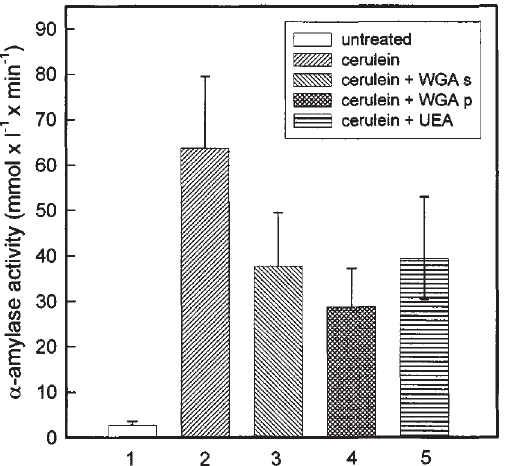
Fig. 4. The (cid:11) -amylase activity (mmol/l (cid:2) min) in the serum of rats after induction of cerulein pancreatitis and ip administration of cerulein and lectins. The results are expressed as mean (cid:6) standard derivation (SD) (groups 1–4, normally distributed) or median (group 5, non-normally distributed). Serum amylase activity of untreated (NaCl) animals (group 1), cerulein treated rats (group 2) and lectin treated animals (groups 3, 4, 5). Significant decrease of enzyme levels by simultaneous WGA administration (compare groups 2 and 3, p < 0.001). Strongest inhibitory effect after additional WGA premedication (compare groups 2 and 4, p < 0.001). WGA showed a stronger decreasing effect on the amylase value in the serum than UEA-I (compare groups 2 and 5, p < 0.001). The results of groups 1–4 are expressed as mean (cid:6) SD; p values were calculated by t -test (normally distributed). The data of group 5 (non-normally distributed) are expressed as median + 25%. This p value was calculated by Wilcoxon